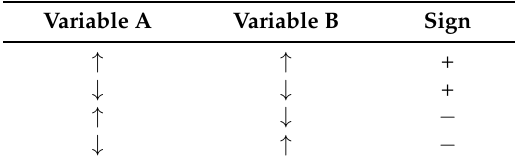
Table 1. Causal relations and polarity: + = a positive causal relation; − = a negative causal relation. Variable A